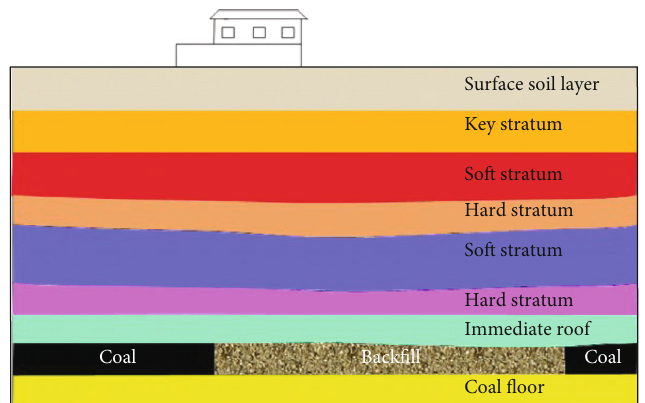
Figure 1: Schematic diagram of overburden rock deformation behavior of solid fi lling